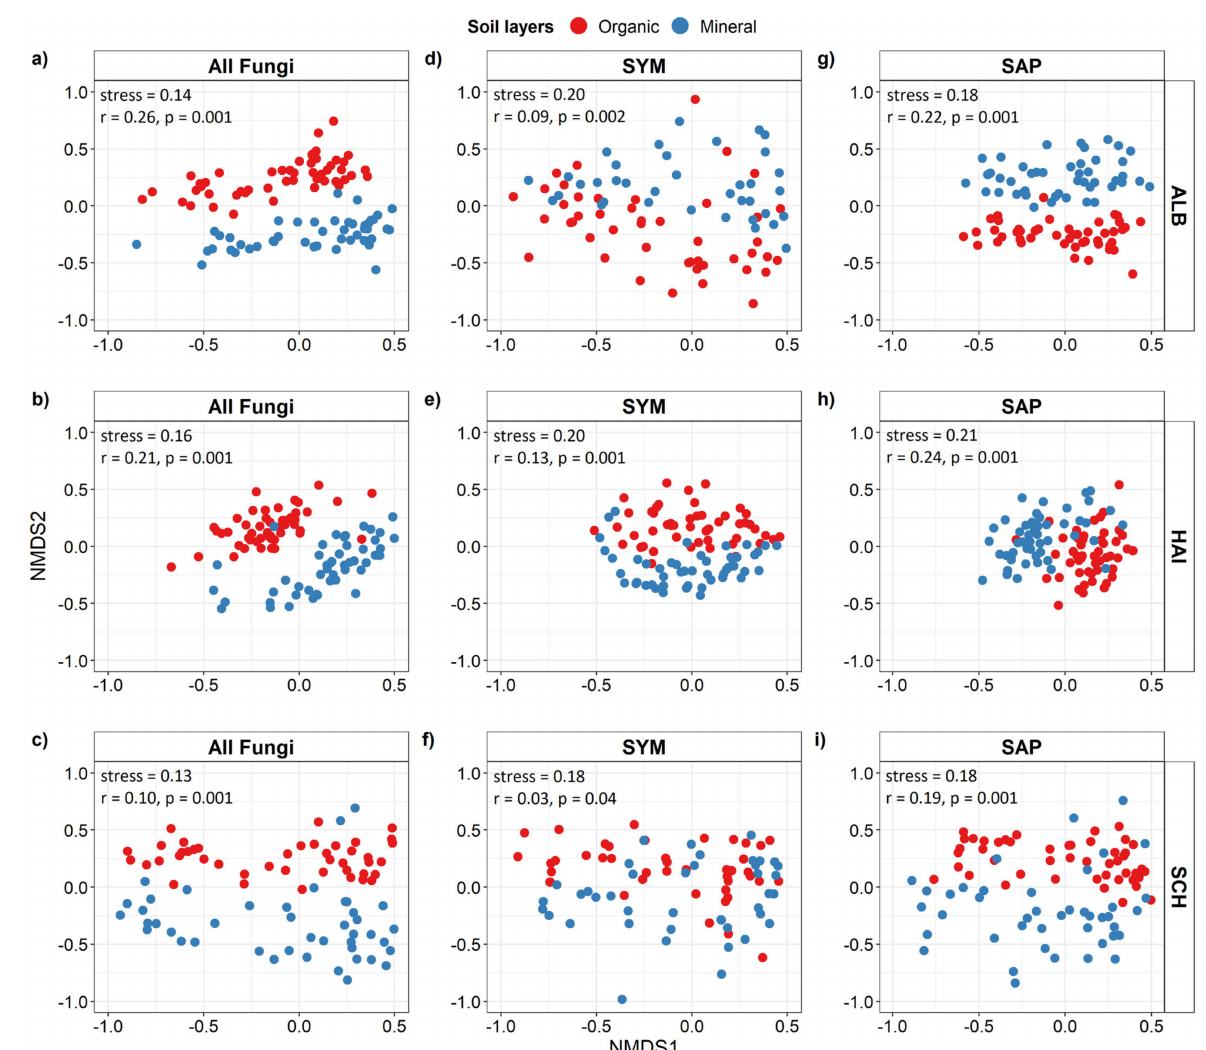
Figure 2. Non-metric multidimensional scaling (NMDS) of root-associated fungal community composition of all (all OTUs, ( a–c )), symbiotrophic (SYM, ( d–f )) and saprotrophic (SAP, ( g–i )) fungi in three biogeographic regions. ALB = Schwäbische Alb, HAI = Hainich-Dün and SCH = Schorfheide-Chorin ( n = 50 per region and soil stratum). Dissimilarities were calculated with the Bray-Curtis distance measure. Red = organic layer, blue = mineral soil. Significant differences of root-associated fungal community composition between soil layers were tested with analysis of similarities (ANOSIM) using 999 permutations and the ‘Bray Curtis’ distance